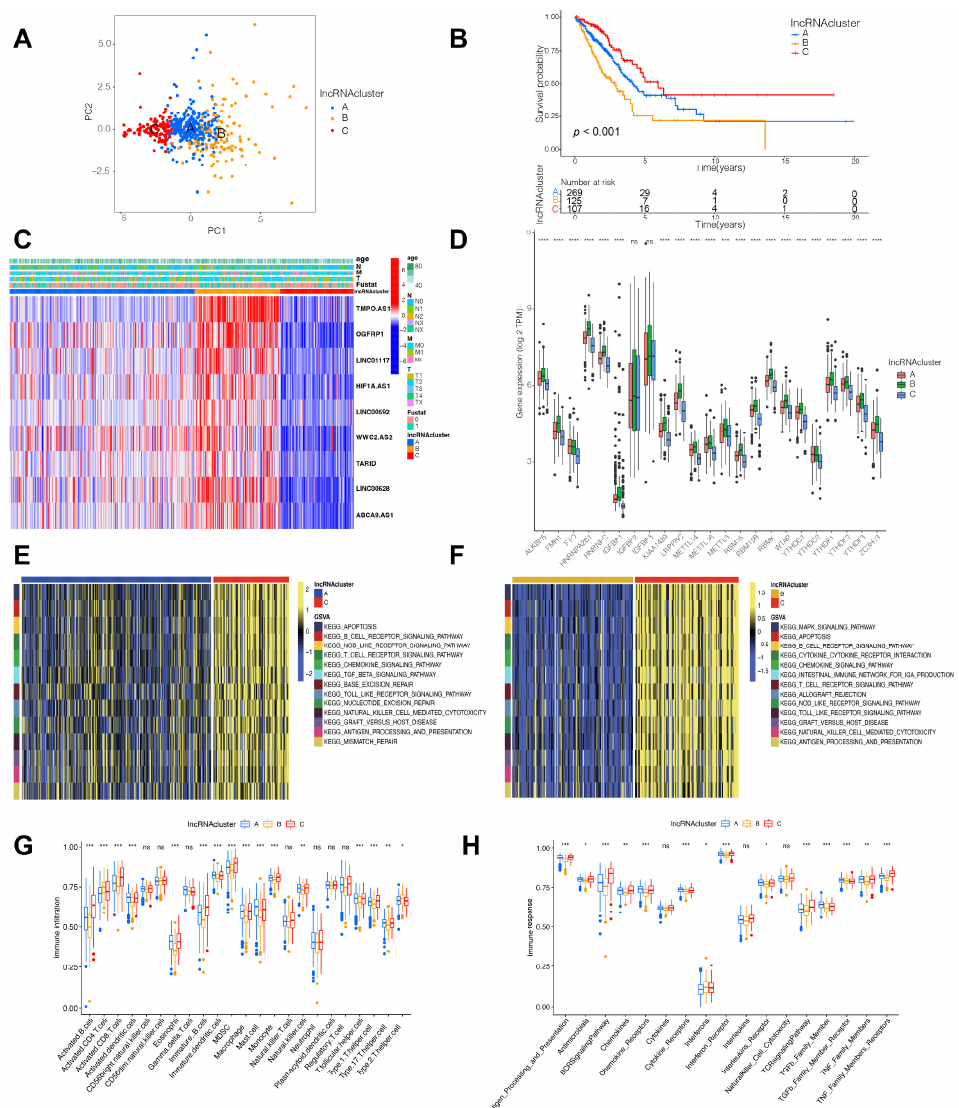
Figure 2. TME cell infiltration characteristics and transcriptome traits in distinct lncRNA clusters. ( A ) Remarkable difference between three lncRNA clusters was plotted via principal component analysis. Patients from TCGA-LUAD were divided into lncRNA cluster A/B/C. PC, principal component; ( B ) Kaplan–Meier curves of survival in TCGA-LUAD cohort with three lncRNA clusters; ( C ) Heatmap displaying clinical features and the expression distributions of 9 hub lncRNAs; ( D ) Expression levels of 23 m6A regulators in three lncRNA clusters, TPM, transcript per million; GSVA enrichment analysis showing the activation states of biological pathways in distinct lncRNA clusters. The heatmap was used to visualize these biological processes, and yellow represented activated pathways and blue represented inhibited pathways; ( E ) LncRNA cluster A vs. C; ( F ) LncRNA cluster B vs. C; ( G ) Characteristics of immune-infiltrating cells in different lncRNA clusters; ( H ) Characteristics of immune responses in different lncRNA clusters. *** p < 0.001, **** p < 0.0001, ns, not